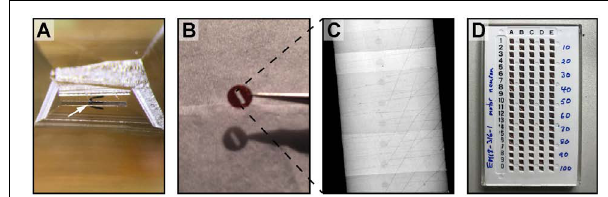
FIGURE 4 | Cutting serial sections for TEM. (A) A block face trimmed for cutting. The worm is oriented transversely in the center of the block face (white arrow). (B) Ribbons of 10–20 sections are picked up on formvar-coated slot grids. (C) A low magnification TEM image of a slot grid, 0.5 mm in diameter. The ribbon of section spans the slot, contributing to the formvar stability. (D) Many grids of serial sections, stored in a grid box, are ready for imaging.